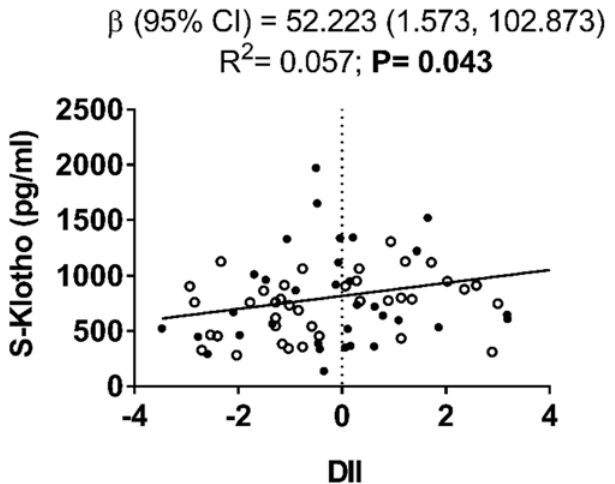
Table 2. Hierarchical regression between the dietary inflammatory index with S ‐ Klotho plasma levels.